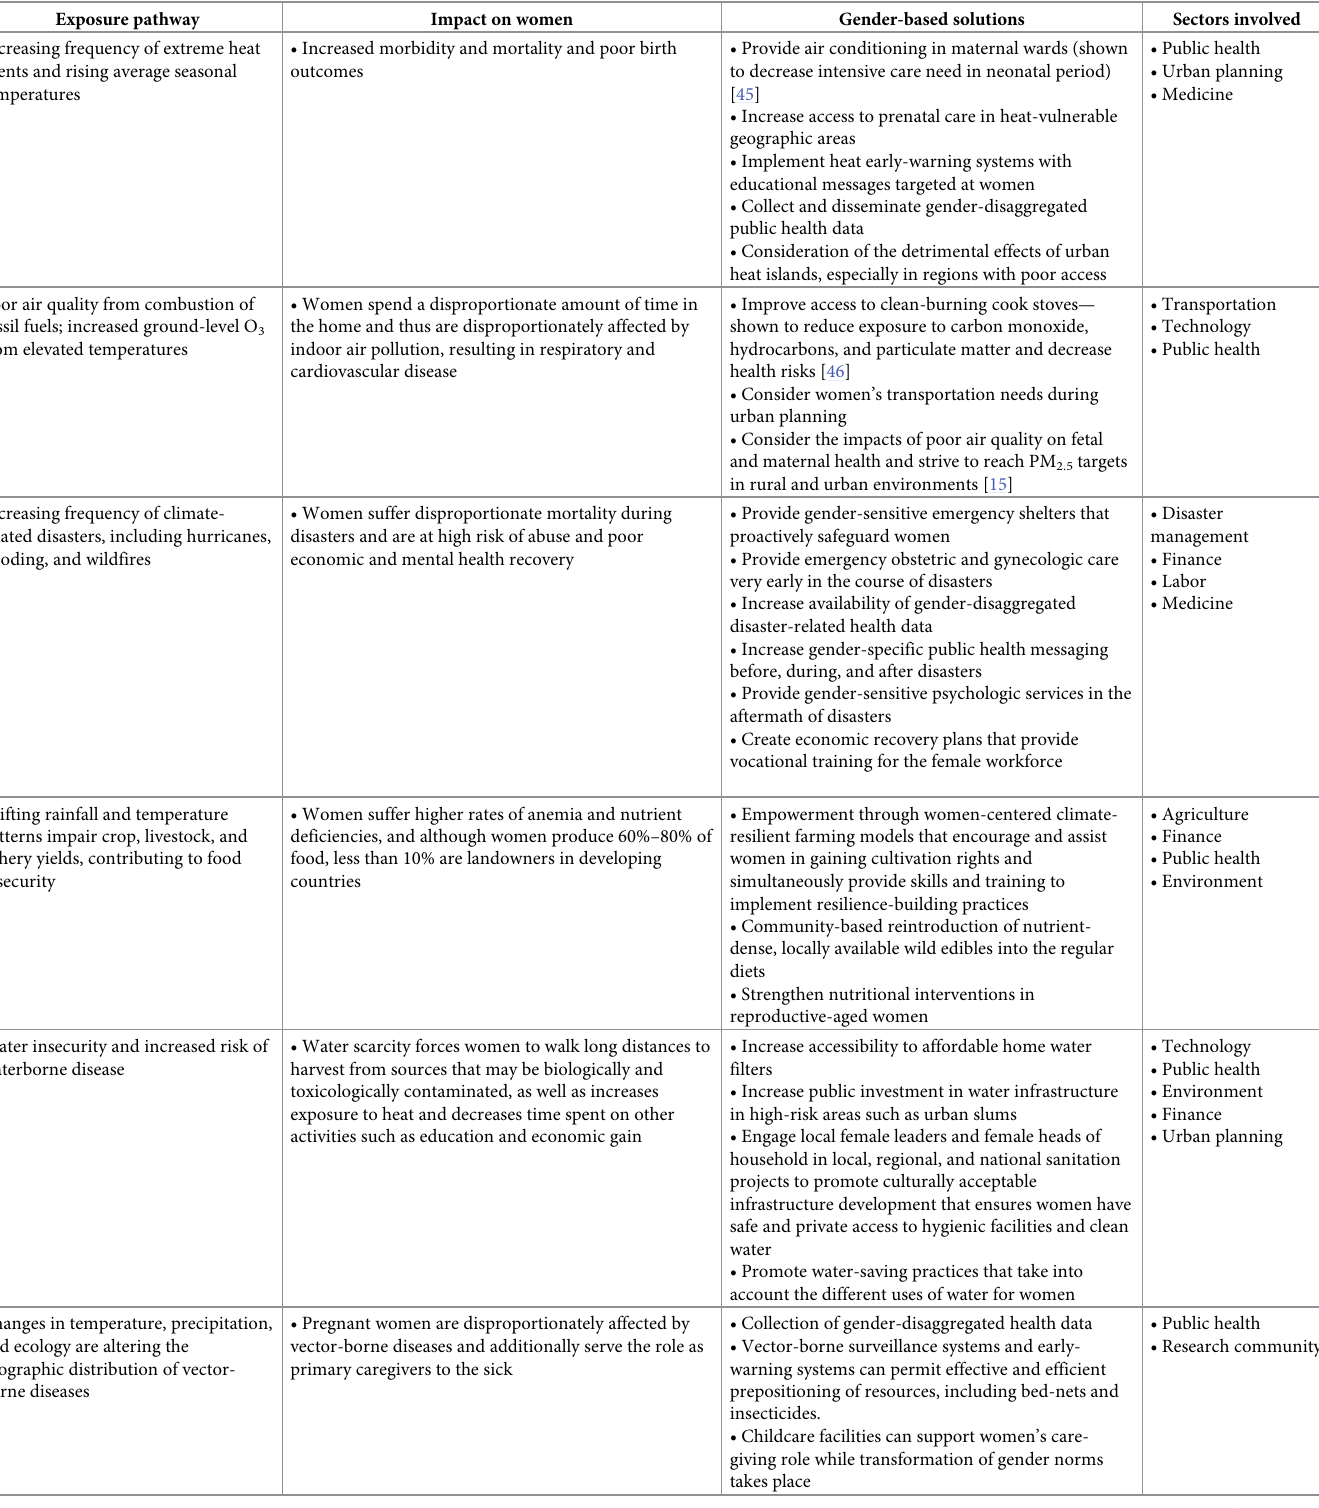
Table 2. Examples of multisectoral solutions to climate change impacts on women’s